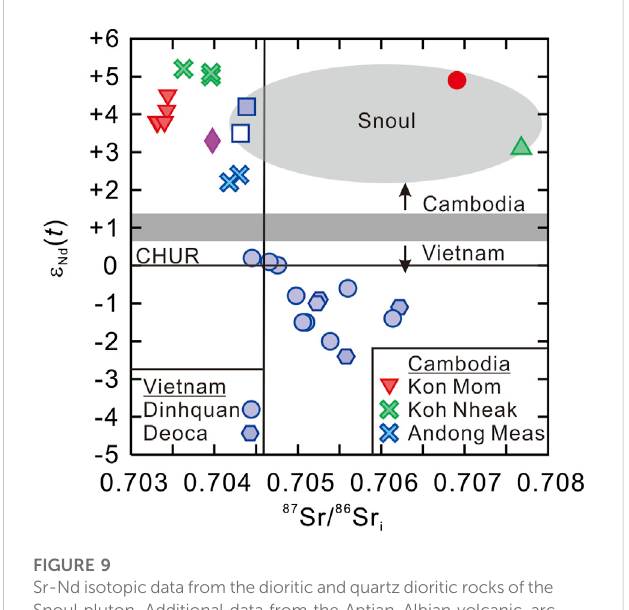
FIGURE 9 Sr-Ndisotopicdatafrom thedioritic andquartzdioritic rocksofthe Snoul pluton. Additional data from the Aptian-Albian volcanic-arc granites from southern Vietnam and eastern Cambodia (Nguyen et al., 2004a; Shellnutt et al., 2013; Cheng et al., 2019). Symbols of the Snoul pluton are the same as in Figure 7.